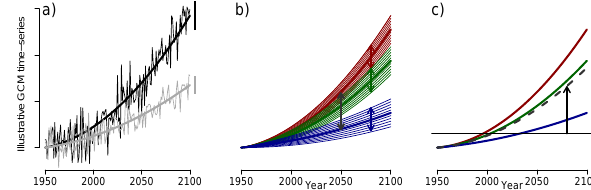
Fig. 9. Separation of the total ensemble uncertainty, p T y , into rel- ative contributions from internal variability, V , uncertainty due to GCM formulation, M y , and GHG concentrations scenario, S y , fol- lowing Hawkins and Sutton (2009). (a) Two illustrative GCM time series (such as temperature or a drought index with a strong upward trend) and their 4th order polynomial fit. The bars to the right de- note the time-independent variability of the annual residuals. Their average over all GCM series and GHG concentrations scenarios de- fines the internal variability, V . (b) Illustrative 4th order polyno- mial fits of GCM time series from three different GHG concen- trations scenarios (colours blue, green, red, analogue to RCP2.6, RCP4.5 and RCP8.5 in Figs. 7 and 8). Thick lines denote the aver- aged time series of the series corresponding to each of the different GHG concentrations scenarios. Coloured arrows indicate the vari- ability within each scenario at a given year. Their average defines the uncertainty due to GCM formulation, M y , for that year. The grey arrow indicates the variability of the intra-scenario average time se- ries at a given year. This variability defines the uncertainty due to GHG concentrations scenario, S y . (c) The intra-scenario averages and their mean (black dashed line). The change signal of a given year, G y , is defined as the change in this mean with respect to the level of the reference year 2006 (horizontal line). See text for de-